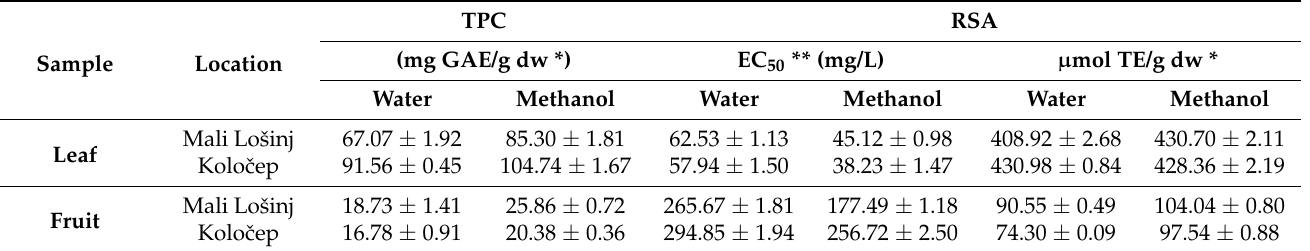
Table 3. Total phenolic content (TPC) and radical scavenging activity (RSA) in strawberry tree ( Arbutus unedo L.) leaf and fruit